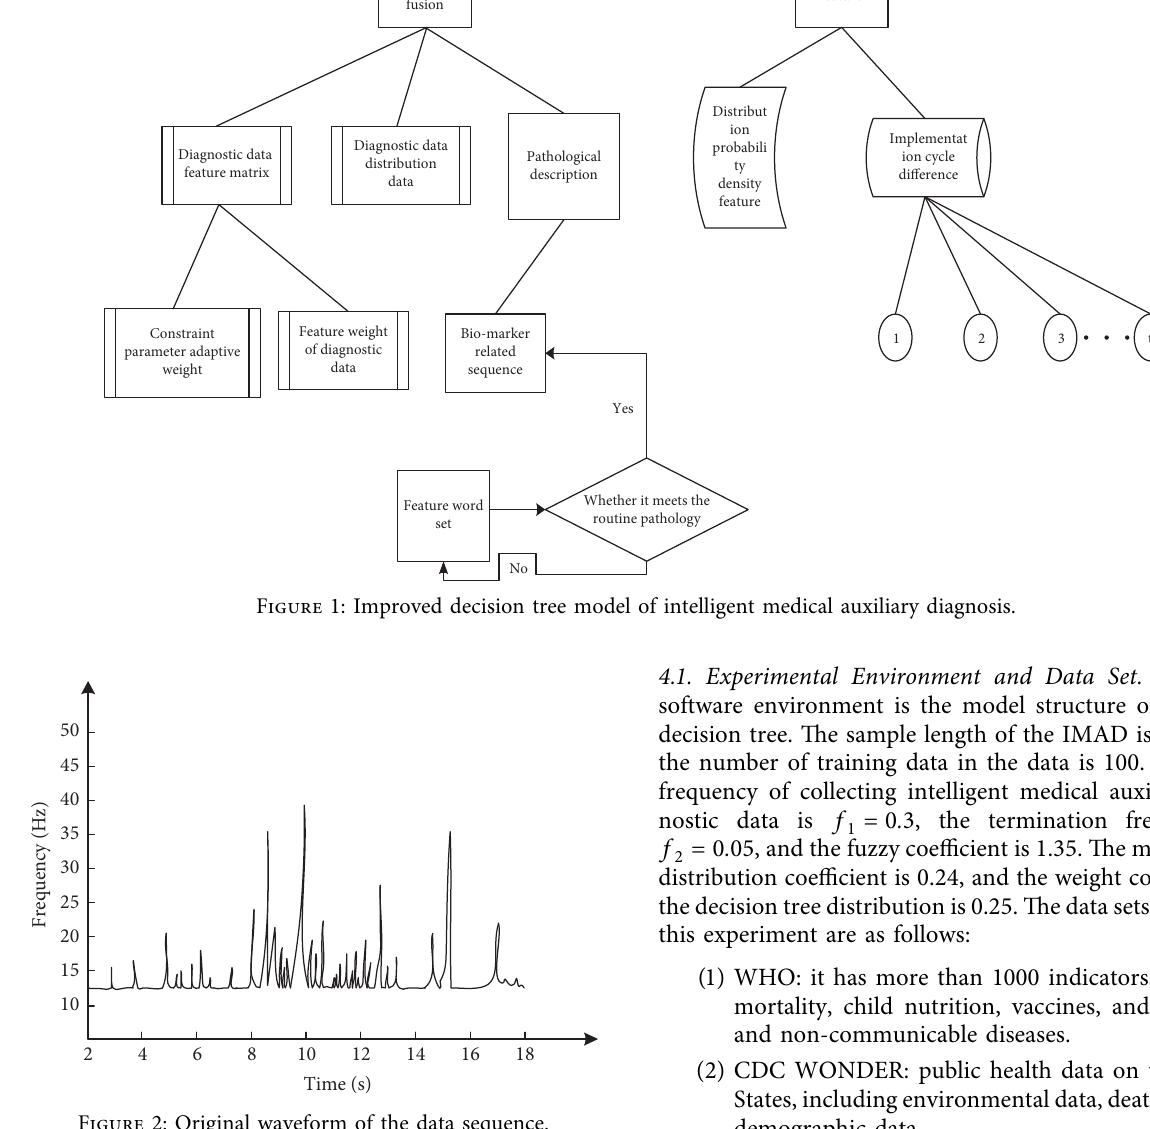
Figure 2: Original waveform of the data